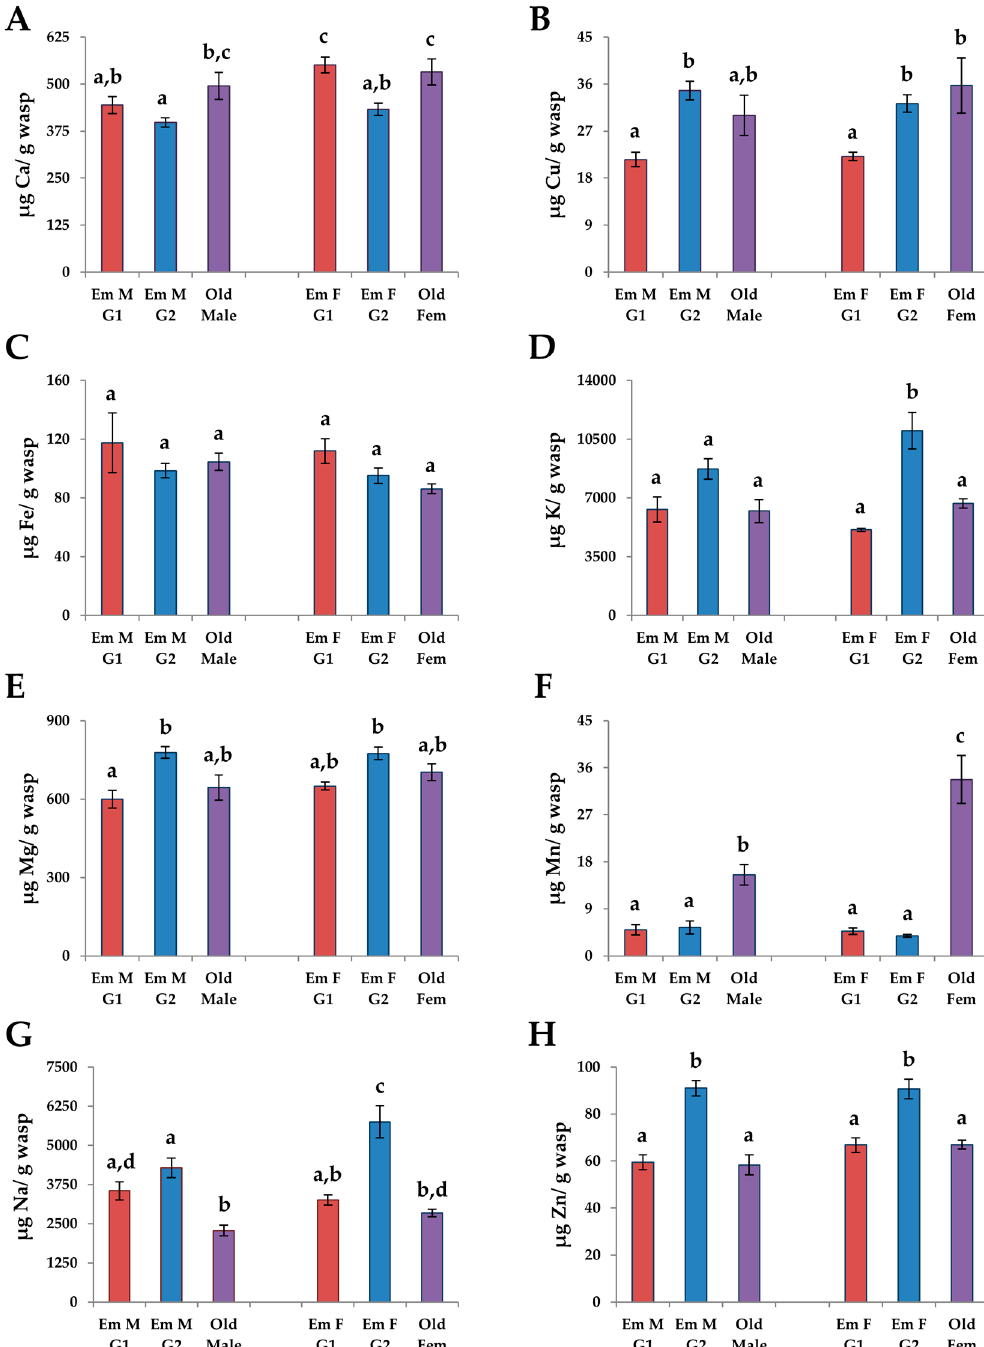
Figure 5. The mean levels of micronutrients: ( A ) Ca; ( B ) Cu; ( C ) Fe; ( D ) K; ( E ) Mg; ( F ) Mn; ( G ) Na; and ( H ) Zn per unit dry mass in eclosing males (N G1 = 9, N G2 = 17) and females (N G1 = 6, N G2 = 16) from the G1 and G2 generations and old adults (both generations combined, N Males = 5, N Females = 6) of Trypoxylon lactitarse . Error bars indicate standard error. For each graph, different letters (a–c) indicate significant differences between groups (MANOVA followed by THSD).